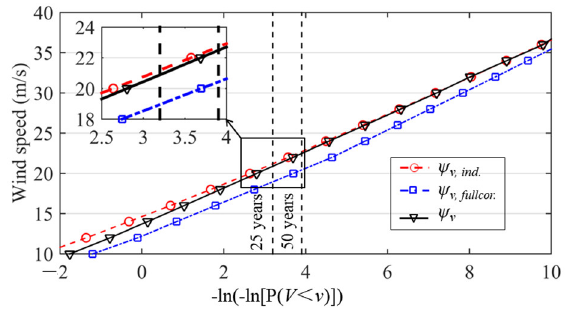
Figure 3. CDF of yearly maximum mean wind speed in Jinan, China.